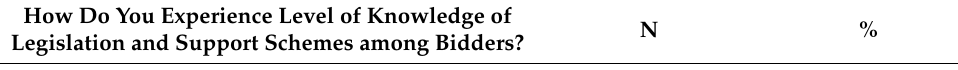
Table 9. Procurers’ assessment of bidders’ knowledge about legislation and public support schemes.